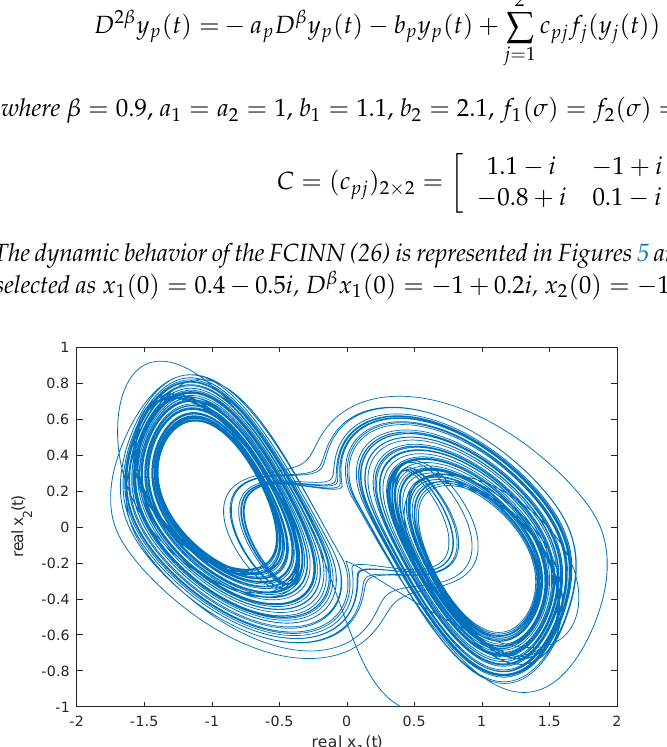
Figure 5. Phase trajectory of real part of the FCINN